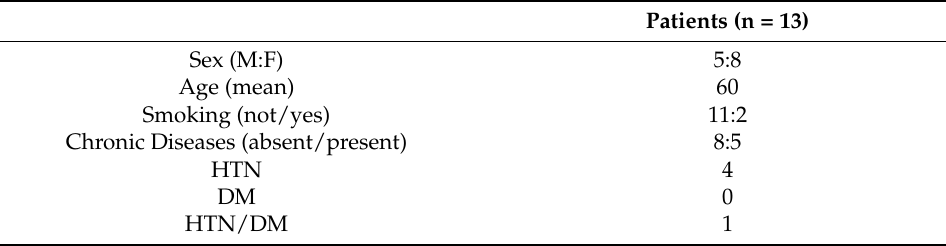
Table 1. Demographic characteristics of patients with peri-implantitis.